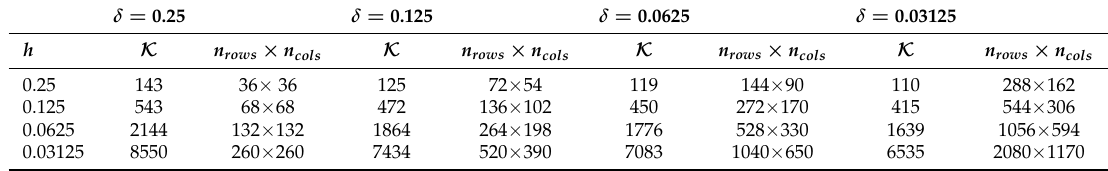
Table 1. The condition number K (rounded to the nearest integer) and the dimensions n rows × n cols of the discretization matrix ( Q ⊗ A + L ⊗ B ) for α = 0.25 as a function of the space step h and the time step δ .